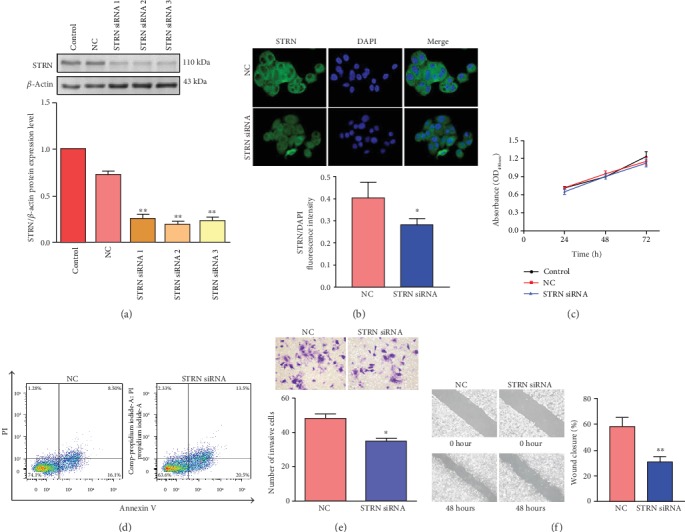
Effect of STRN depletion on the proliferation, apoptosis, invasion, and migration capacities of Huh7 cells. (a) Western blot was conducted to detect the inhibitory effect of STRN siRNA in Huh7 cells. (b) Inhibition of STRN in Huh7 cells was confirmed by immunofluorescence assay (original magnification, ×200). (c) The Huh7 cell proliferation potential was measured by MTT assay upon STRN downregulation via siRNA. (d) Cell apoptosis was assessed using flow cytometric analysis in STRN-downregulated Huh7 cells. (e) The invasive ability of Huh7 cells was suppressed by STRN knockdown, as assessed by the transwell invasion assay. Representative bright-field microscopy images are shown (original magnification, ×200). (f) The migratory capacity of Huh7 cells was inhibited by STRN knockdown, as assessed by the wound healing assay (original magnification, ×100). ∗P < 0.05 and ∗∗P < 0.01vs. NC. Abbreviation: NC: negative control.